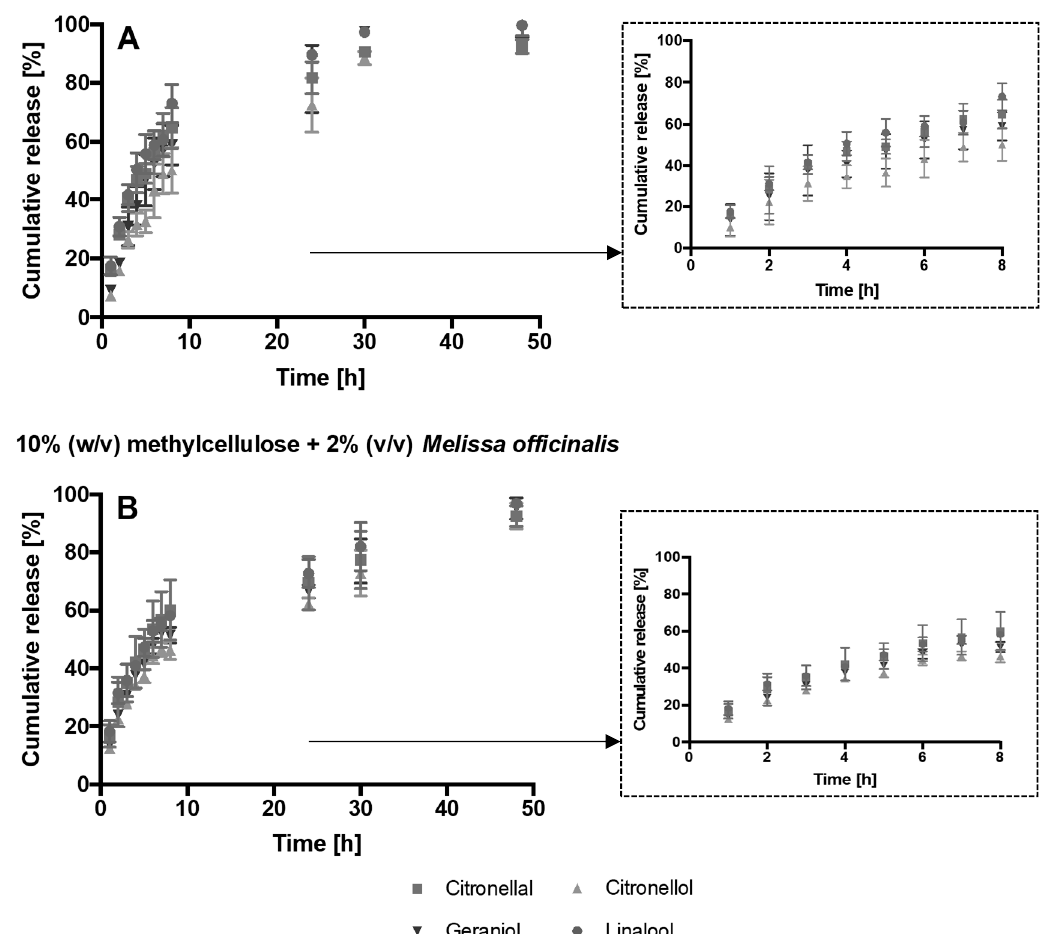
Figure 2. Percentage cumulative release of citronellal (square), citronellol (triangle), geraniol (inverted triange), and linalool (circle) of 10% ( w / v ) methylcellulose and 1% ( v / v ) Melissa officinalis ( A ), and 10% ( w / v ) methylcellulose and 2% ( v / v ) Melissa o ffi cinalis ( B ). A zoom of the percentage cumulative release between 0 and 8 h is also shown in the dashed